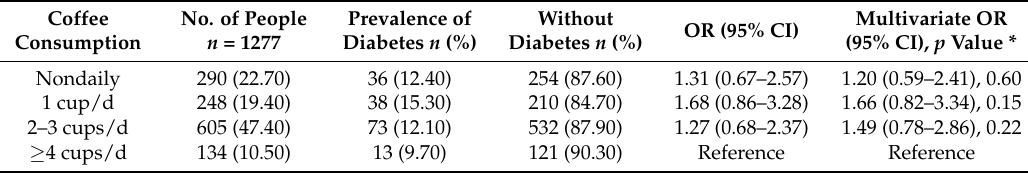
Table 2. Relationship between coffee consumption and prevalence of diabetes after adjustment for potential confounding